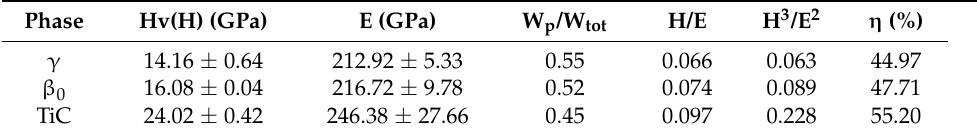
Table 3. Specific results of nanoindentation of TiAl composite coatings.